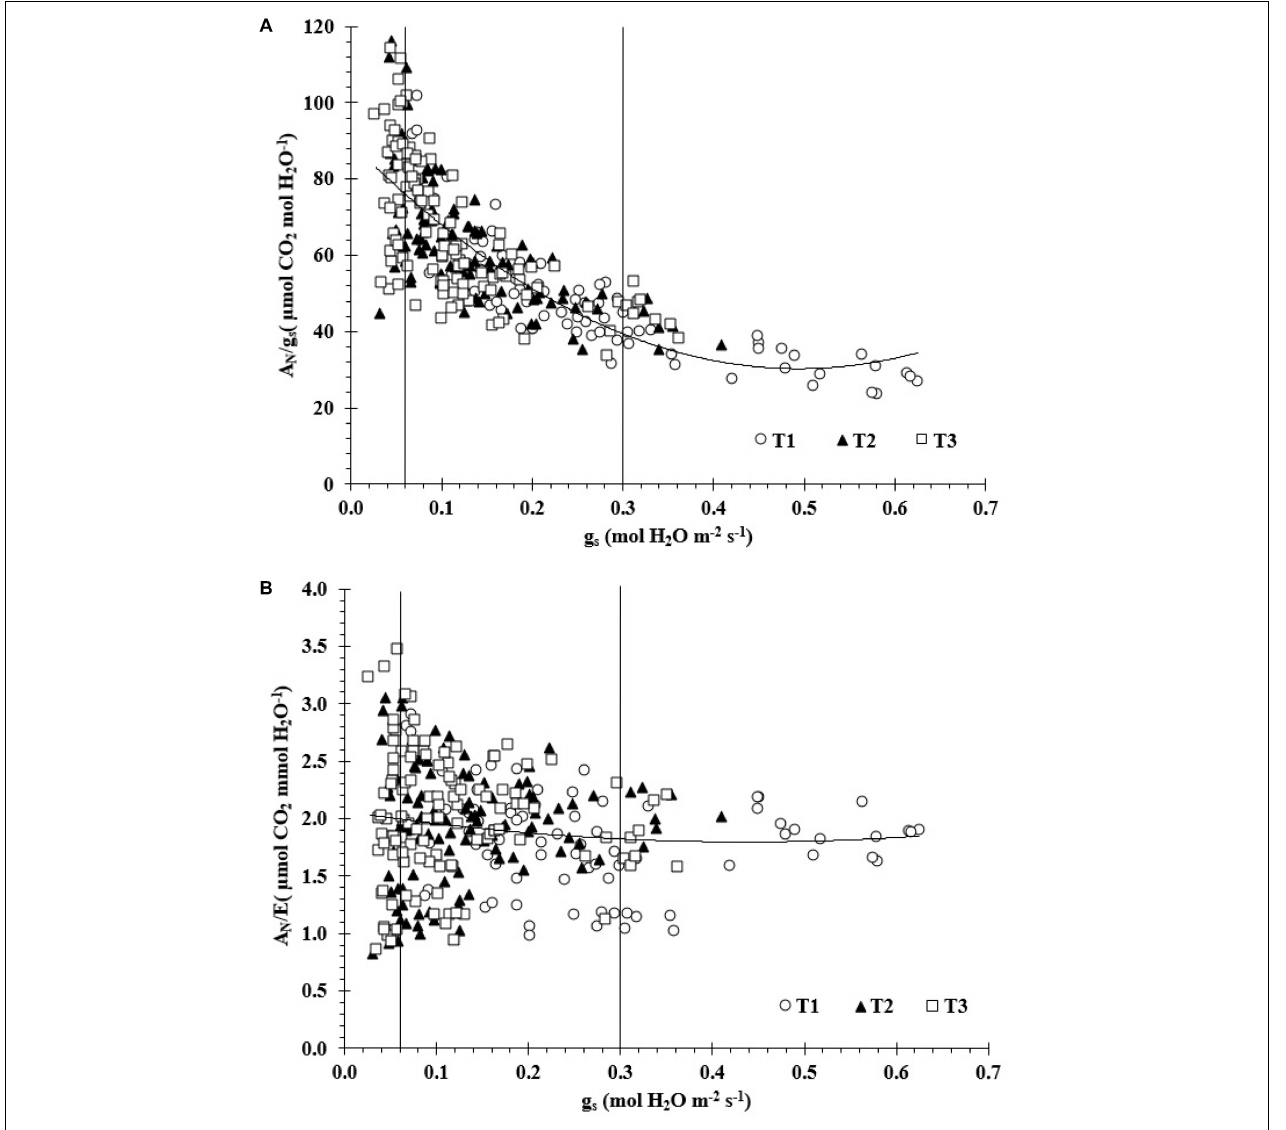
FIGURE 2 | (A) The relationships between intrinsic water use efficiency versus stomatal conductance (g s ) (A N /g s = 242.81g s2 –239.68g s +89.497; R 2 = 0.62) and (B) between water use efficiency versus g s (A N /E = 1.4086g s2 –1.2237g s +2.0654; R 2 =